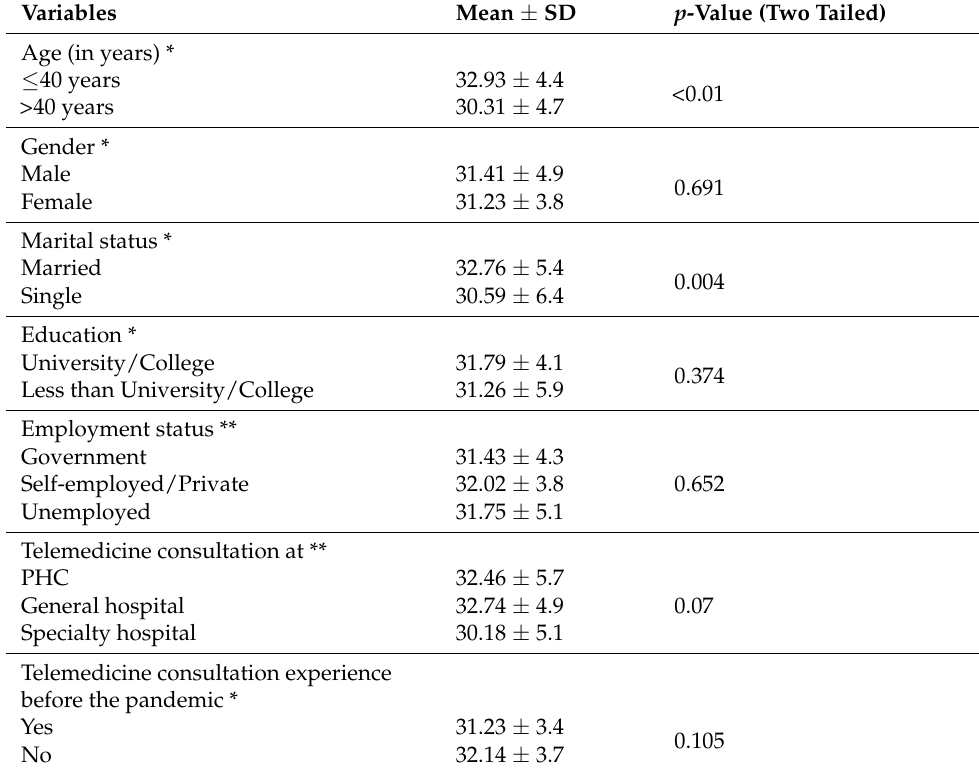
Table 2. Comparison of telemedicine scores with patients’ background characteristics.